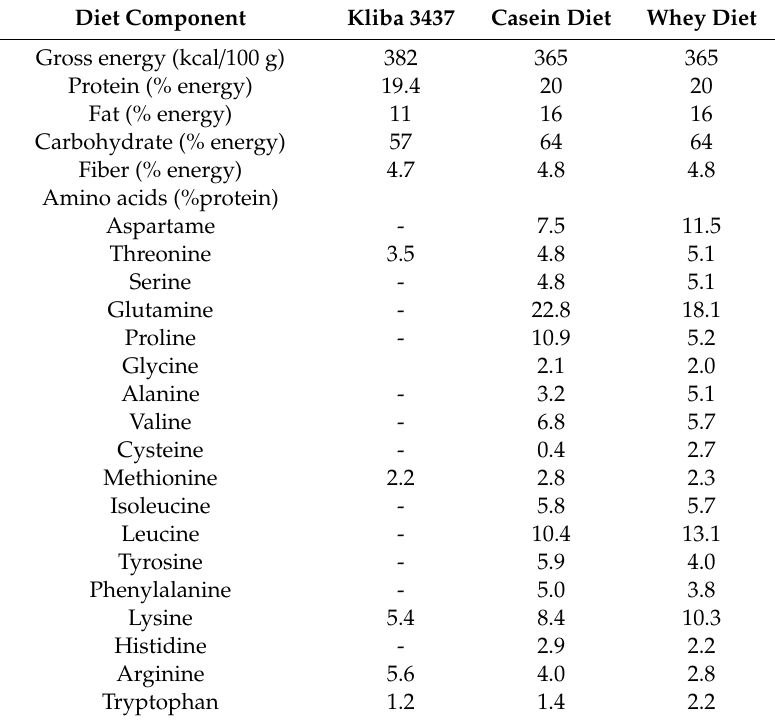
Table 1. Composition of the study